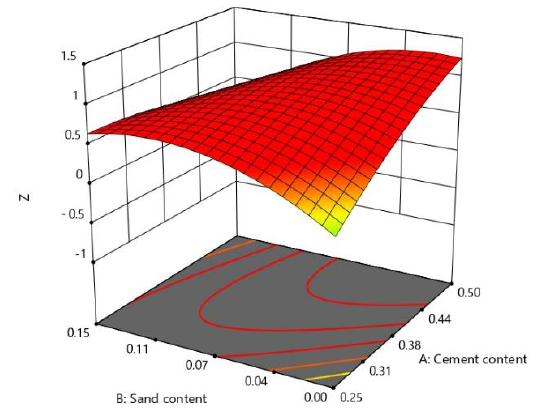
Figure 9. Response surface diagram.